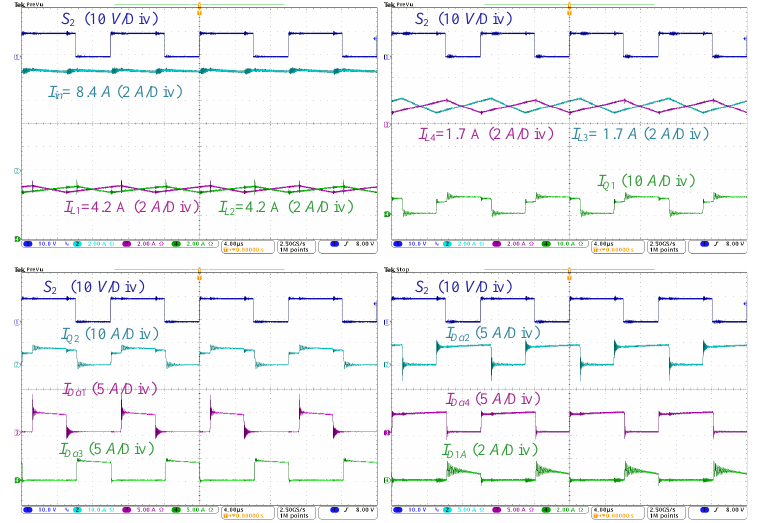
Figure 12. Current passing through the MOSFETs, inductors and diodes D a 1 – D a 4